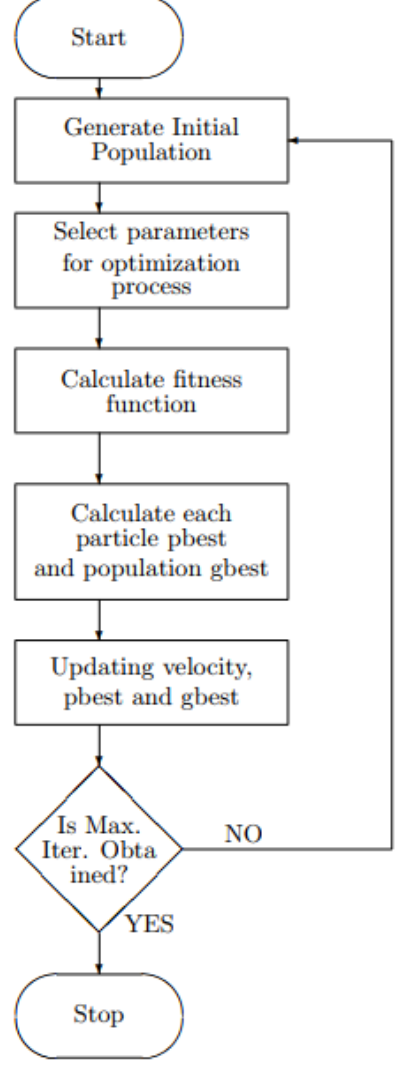
Figure 2. A Flowchart of PSO